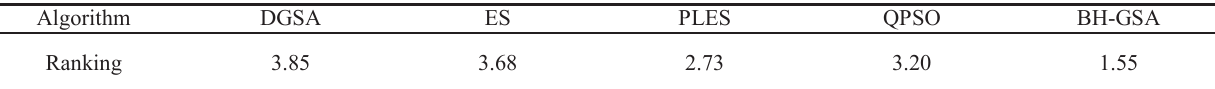
Table 19. Average ranking of algorithms based on the average best-so-far for multimodal test functions of set 2.